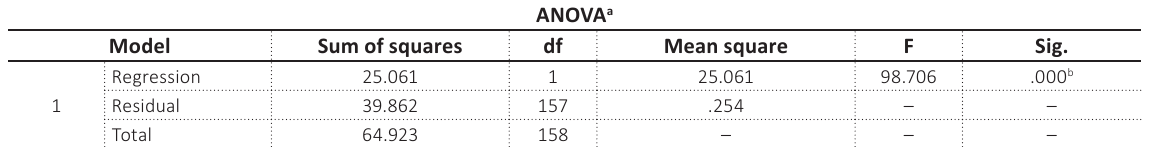
Table 7. ANOVA analysis for H01